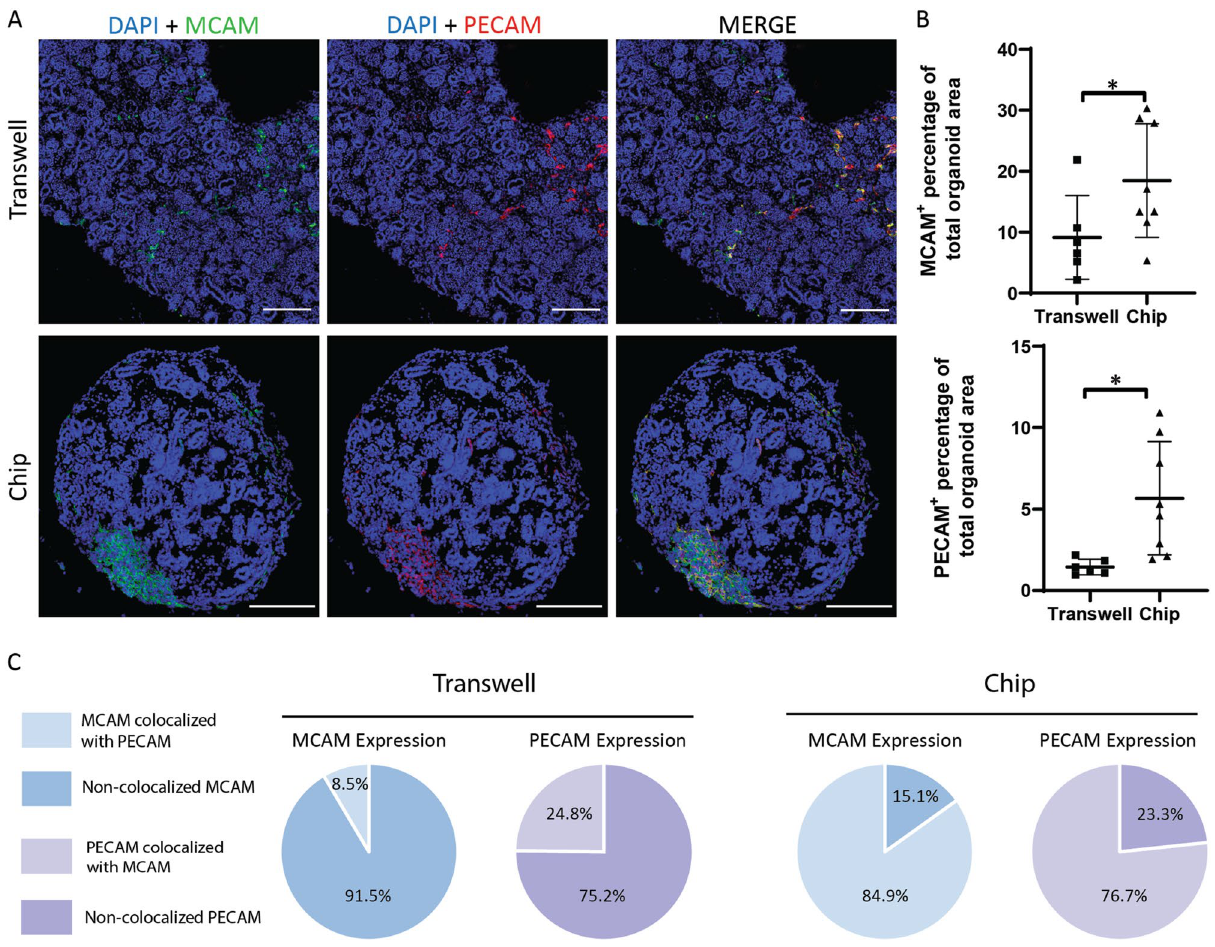
Figure 2. Kidney organoids cultured on chip show expanded EC populations and directed endothelial maturation patterns. ( A ) Immunofluorescent images of DAPI-MCAM-PECAM co-staining showing kidney organoids cultured on transwell and on chip, scale bars = 200 µm. ( B ) Statistical analysis of MCAM and PECAM expression in kidney organoids based on percentage of total area. Organoids cultured on chip (n = 8) showed higher areas positive for both MCAM and PECAM in comparison to organoids cultured on transwell (n = 6) . Each data point = one organoid. * = P < 0.05. Error bar = SD. ( C ) Colocalization analysis showing percentages of colocalized and non-colocalized markers in kidney organoids cultured on transwell and on